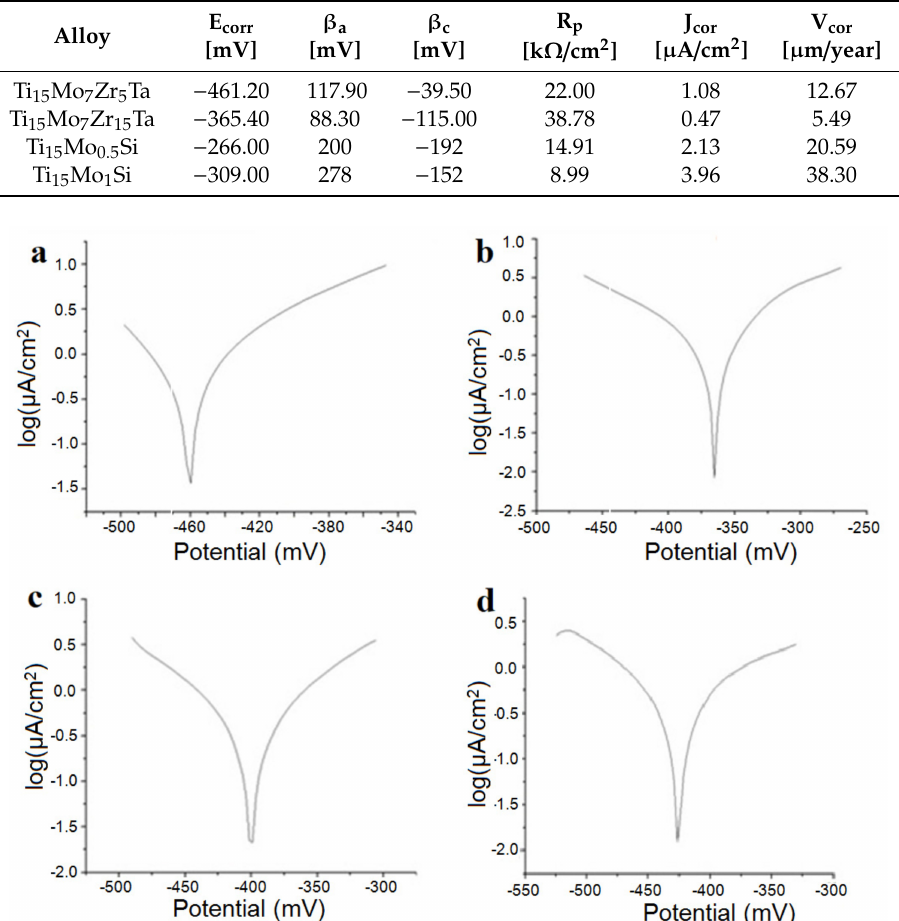
Figure 5. Diagrams of the investigated alloys by corrosion testing in Ringer’s solution of the